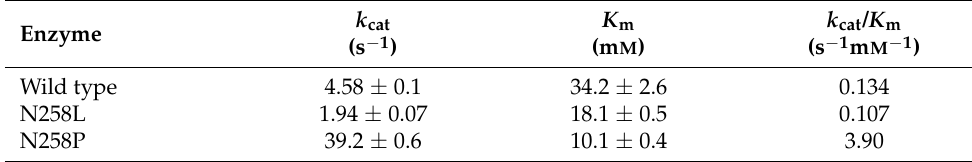
Table 4. Kinetic parameters of BspAG13_31A variants to